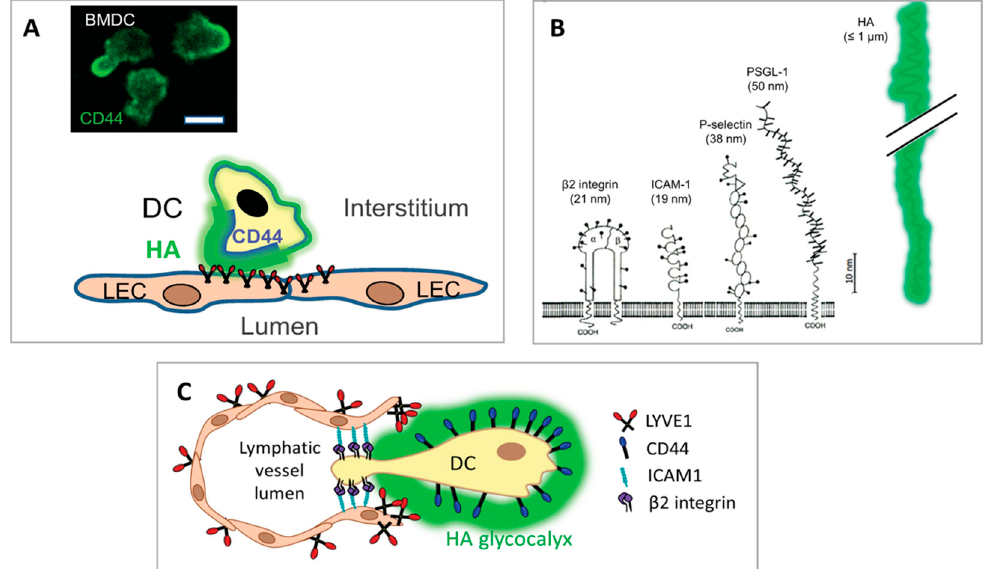
Figure 4. Dynamics of the DC HA glycocalyx and its influence on engagement of underlying adhesion receptors with lymphatic endothelium during vessel entry. ( A ) Initial contact with lymphatic endothelium triggers polarisation of migrating DCs and redistribution of CD44 to the adhesive uropod as observed by confocal microscopy [114] and as depicted in the illustration shown. Bar = 10 μ m. ( B ) The estimated length of HMW HA chains in the glycocalyx ( ≤ 1 μ m) extends beyond that of other key underlying adhesion receptors such as leucocyte integrins and their ligands on the DC surface, likely positioning the LYVE-1 • HA axis for making the first adhesive contacts between DC and endothelium during the process of transmigration. ( C ) Speculative organisation of DC • endothelial contacts during transmigration and the possible influence of the HA glycocalyx on underlying β 2 integrin accessibility and adhesive function. The illustration depicts the possible imposition of focal clustering of DC integrins by the bulky HA chains, enabling their conformational activation and subsequent contribution to endothelial adhesion via ICAM-1 during diapedesis [128]. How and when integrins become accessible beneath the glycocalyx is, however, still unclear. The confocal image in panel A is from Johnson et al. 2021, [114] and the cartoon in panel B is adapted from Barclay et al. 1997, [129] with permission from the publisher (Elsevier).